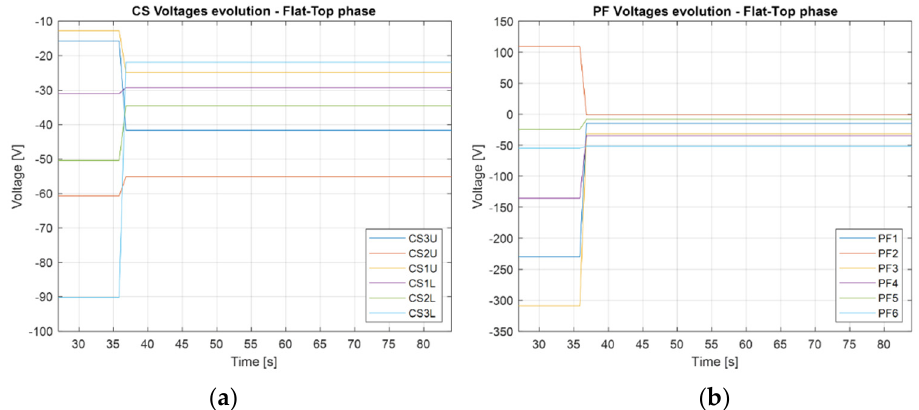
Figure 5. Plasma shapes of SOF and EOF configurations of the SN scenario.